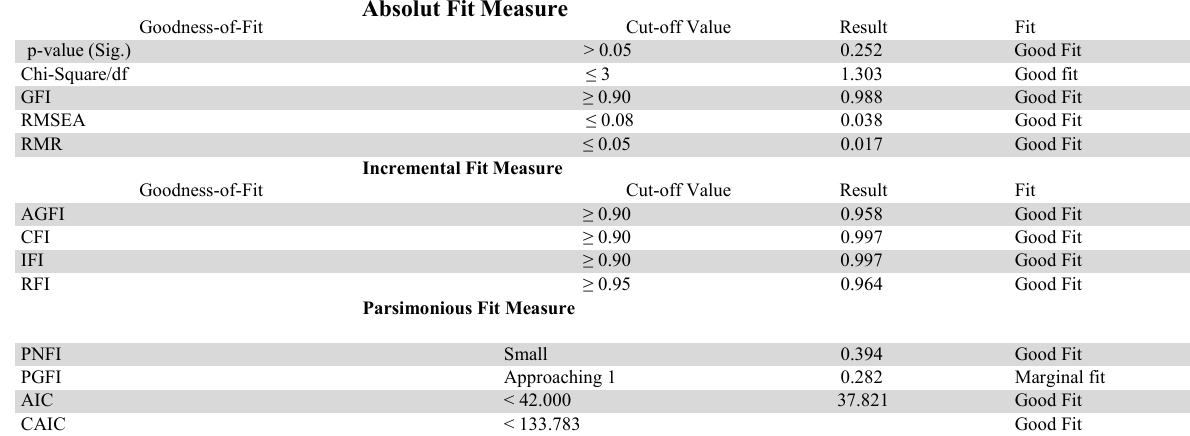
Goodness of Fit of Confirmatory Factor Analysis (CFA) Model of Job Involvement